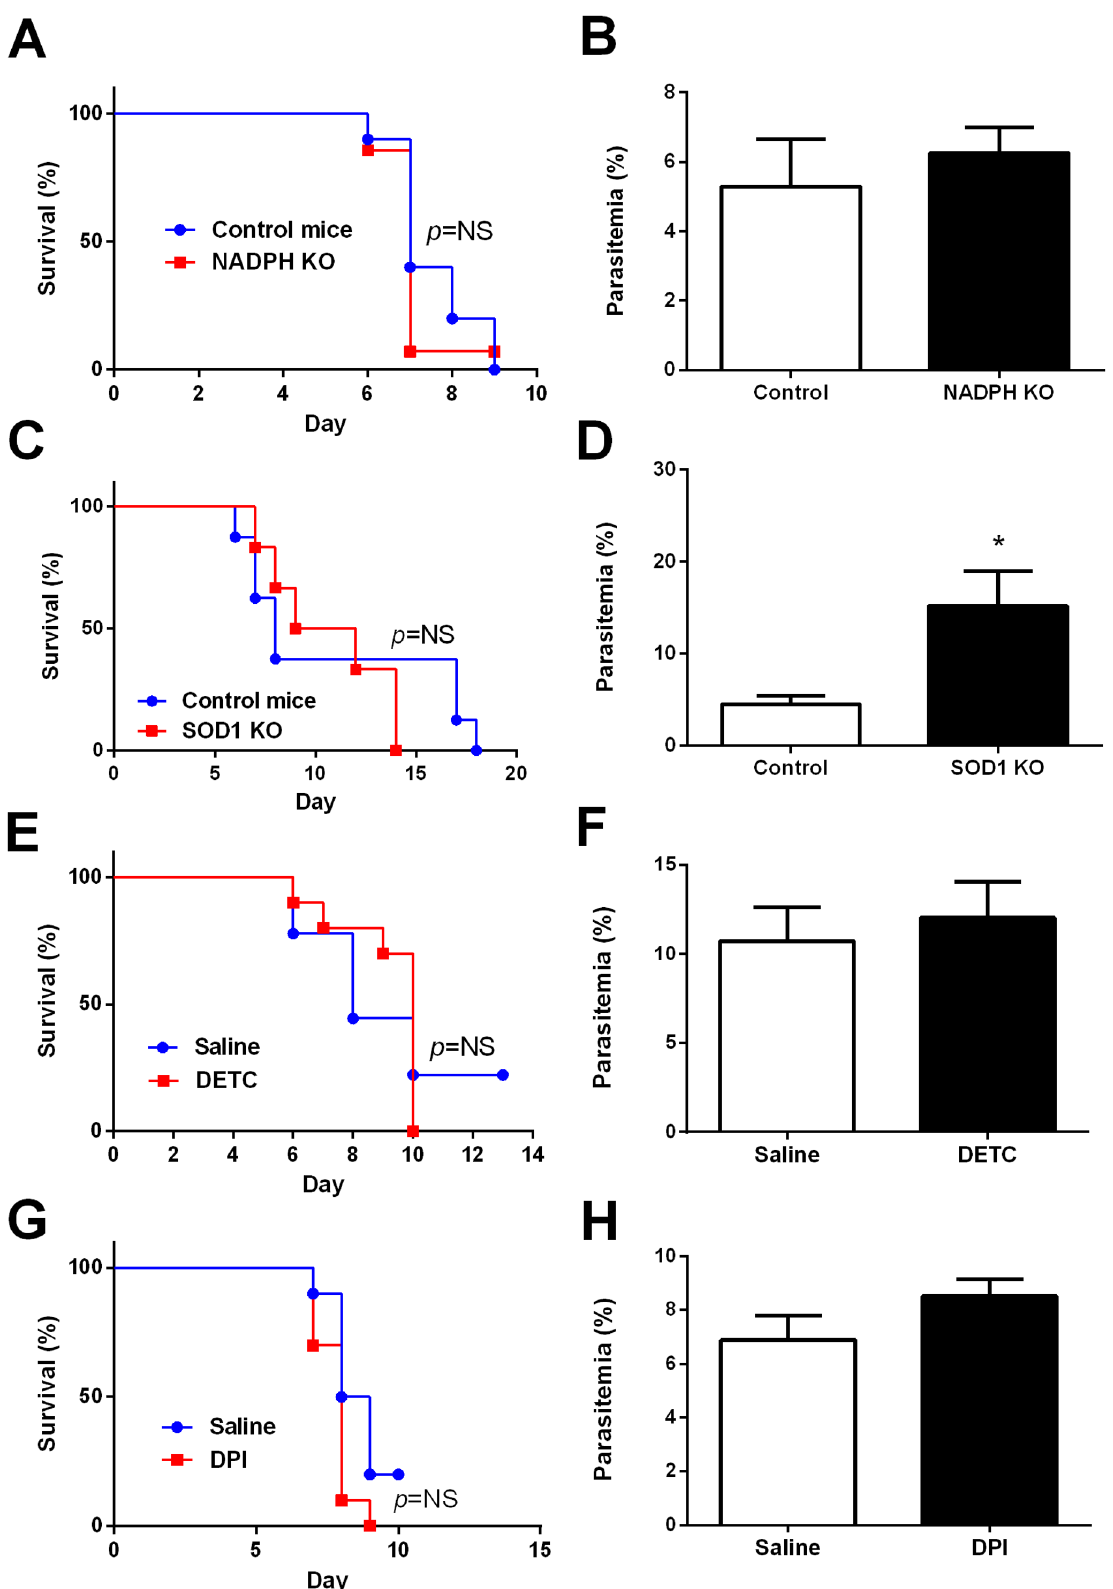
Figure 8. Cerebral malaria in mice deficient for NADPH oxidase or SOD1 or in the presence of DETC or DPI. Plasmodium berghei Anka parasitized red blood cells (10 6 ) were injected intraperitoneally (i.p.) into A, mice knocked out (KO) for NADPH oxidase or controls (n=8). B, An aliquot of blood was collected at day 6 to determine parasitemia. C, P. berghei Anka infection of mice KO for SOD1 (n=8). D, An aliquot of blood was